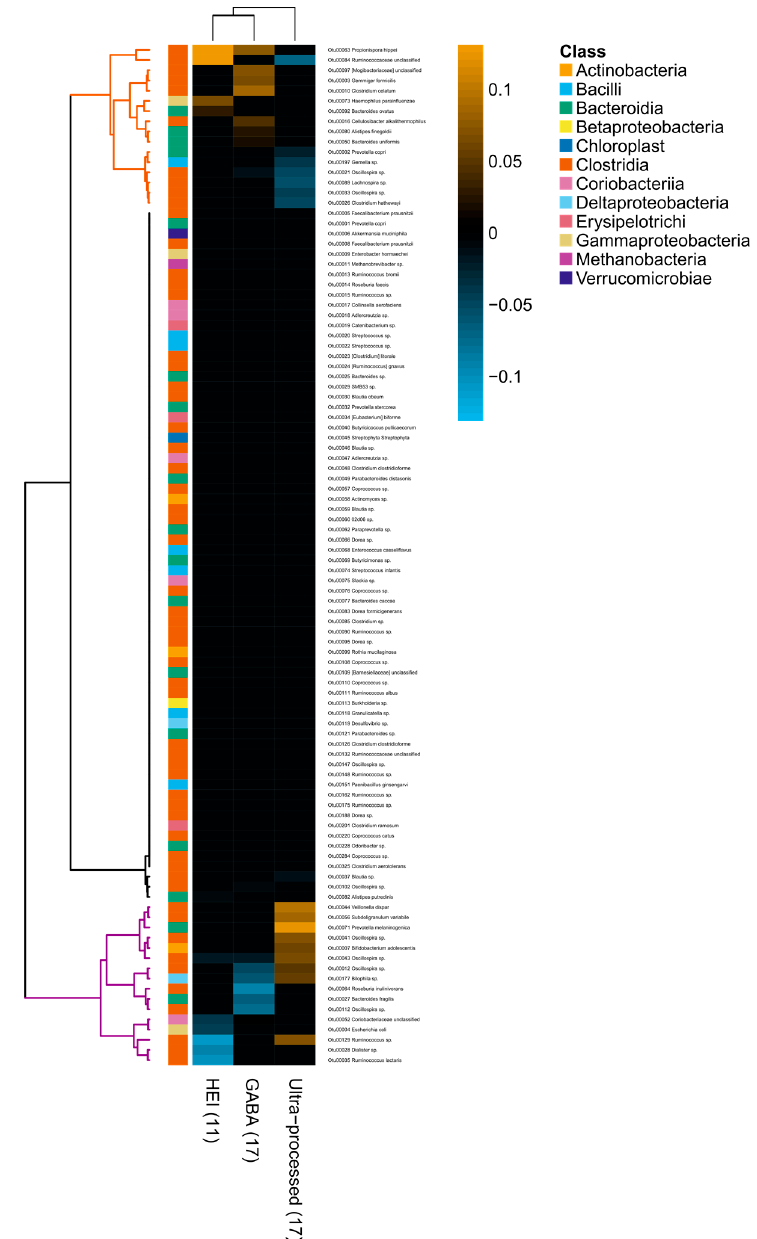
Figure 3. Heatmap showing Spearman’s correlation coefficients between operational taxonomic unit (OTU) relative abundance and diet quality. The set of OTUs associated with multivariable-adjusted diet quality indexes were obtained with a regression-based random-forest machine-learning algorithm. Dendrograms obtained by hierarchical Ward-linkage clustering. The colored branches of the dendrogram are for illustrative purposes: brown branches highlight OTUs associated with diets of high quality, while purple branches highlight OTUs associated with diets of low quality. The taxonomic classification at the class level of each OTU is noted at the left side of the heatmap. Values in parentheses next to quality indexes indicate the number of OTUs selected by the random forest. HEI = adapted Healthy Eating Index 2015; GABA = Colombian Food-Based Dietary Guidelines.